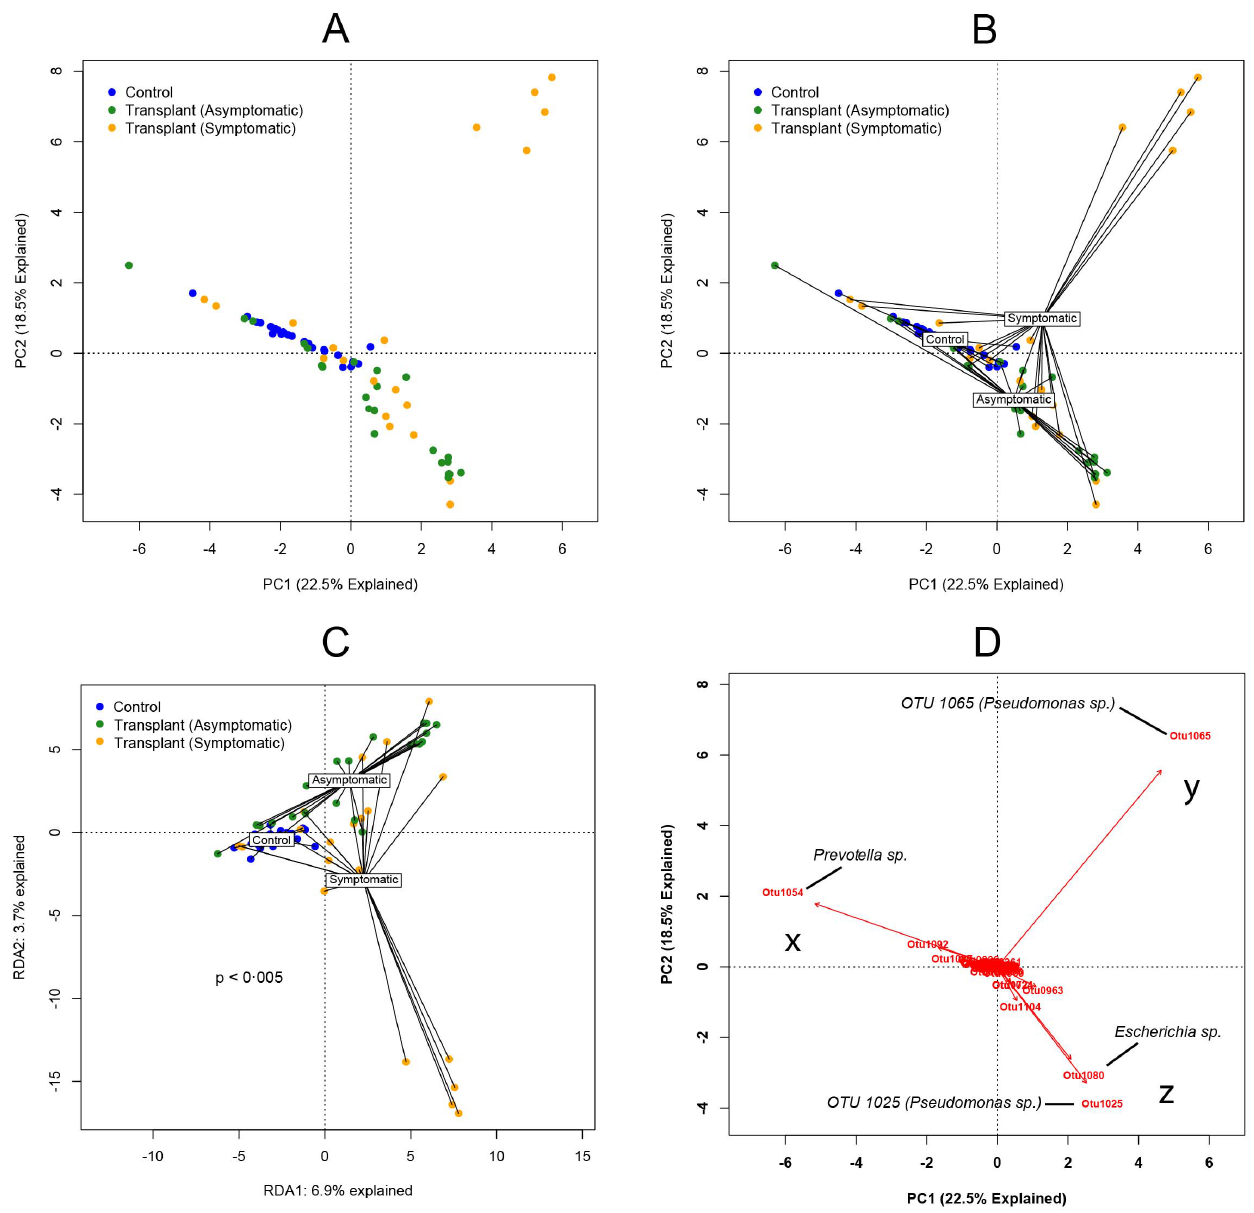
Figure 3. Ordination analyses of bacterial communities detected in BAL samples. Unsupervised principal component analysis (PCA): labeled by specimen group (A) and with specimen group centroids labeled (B) C: Ordination constrained by specimen group (RDA). Group dissimilarity tested using ANOVA permutation test. D: Biplot analysis of PCA plot with prominent OTUs labeled.